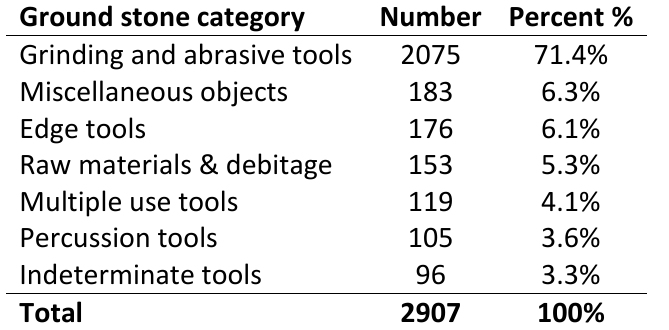
Figure 1. Map of northern Greece showing the location of Avgi. Table 1. Ground stone categories from Neolithic Avgi and their